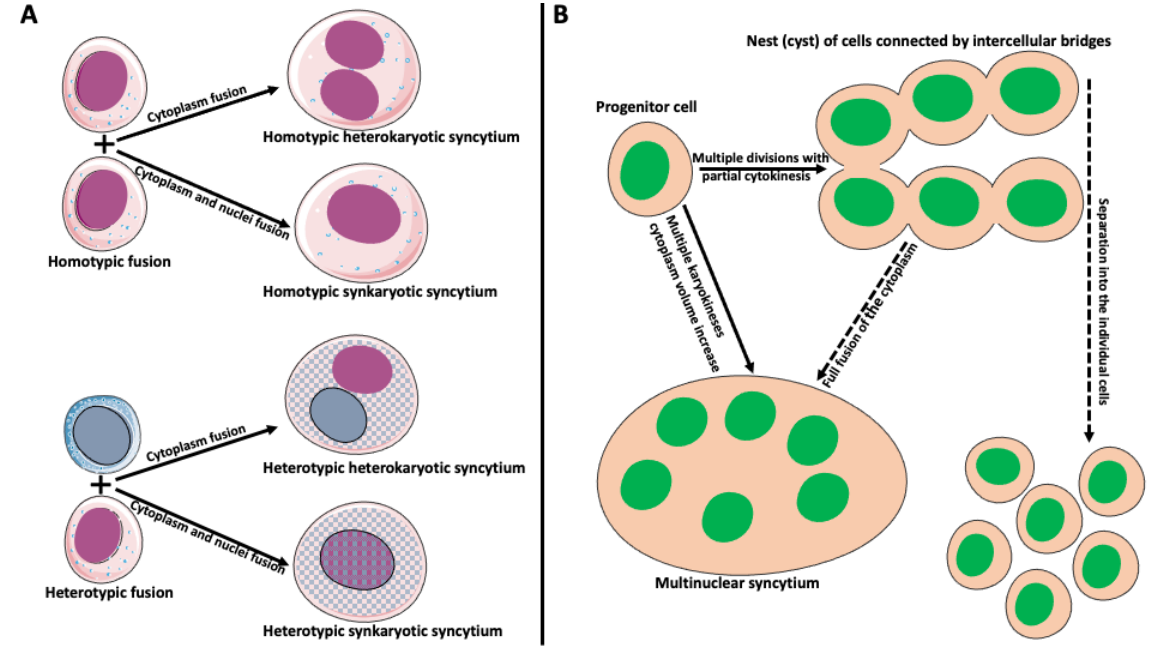
Figure 2. Types and origin of syncytia. ( A ) Syncytium derived from the fusion of identical cells is called homotypic syncytium. Homotypic fusion of cell cytoplasms creates homotypic heterokaryotic syncytium with multiple nuclei. Homotypic fusion of cell cytoplasms and nuclei creates homotypic synkaryotic syncytium. Syncytium derived from the fusion of different cell types is called heterotypic syncytium. Heterotypic fusion of only cell cytoplasms creates heterotypic heterokaryotic syncytium with multiple nuclei of different origins. Heterotypic fusion of cell cytoplasms and nuclei creates heterotypic synkaryotic syncytium. ( B ) Origin of syncytia during development. In some instances, progenitor cell divides multiple times with partial cytokinesis forming a group (called nest or cyst) of descendant cells connected by cytoplasmic bridges. Eventually, these cells either separate into individual cells (for example, in frog or mammalian oogenesis) or fuse to form multinuclear syncytium (for example, nurse cell syncytium in insect telotrophic ovary). In other instances, for example, during early embryogenesis in Drosophila , the nucleus of the progenitor cell divides multiple times, creating a multinuclear cell (syncytium), which eventually cellularizes into individual cells.